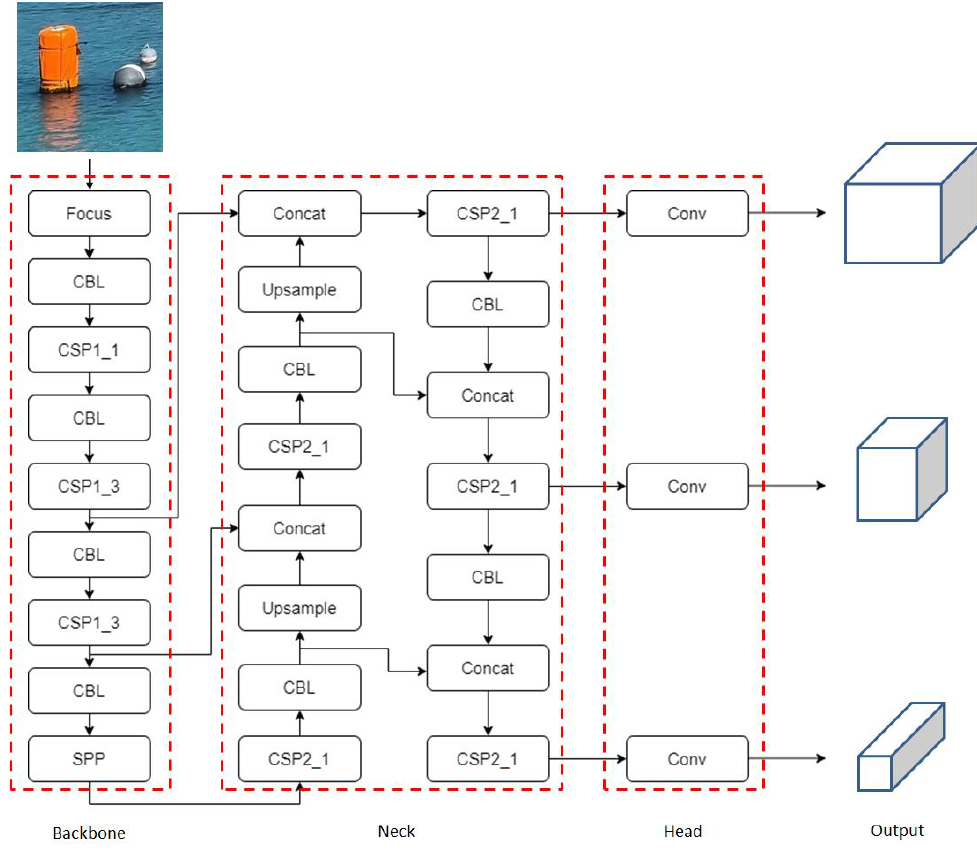
Figure 1. YOLOv5 architecture.